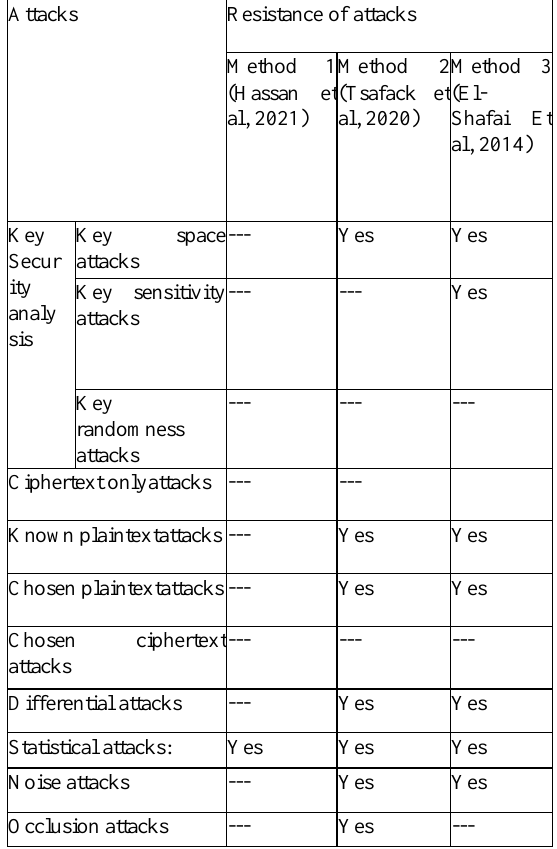
Table 3 : security analysis’s comparison of existing